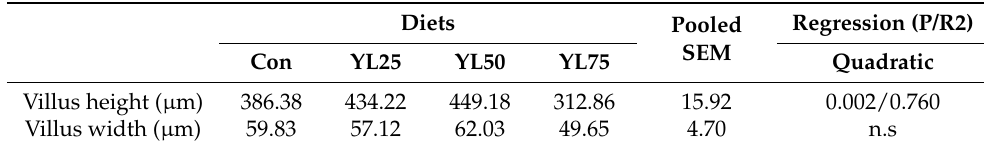
Table 3. Histological parameters of mid-intestinal in juvenile largemouth bass fed different YL inclusion diets *.